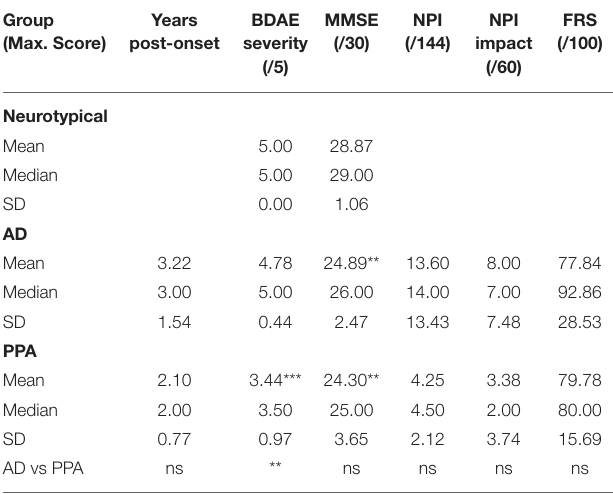
TABLE 1 | Years post onset, communicative, general cognitive, neuropsychiatric, and functional status of the participants. Group (Max.